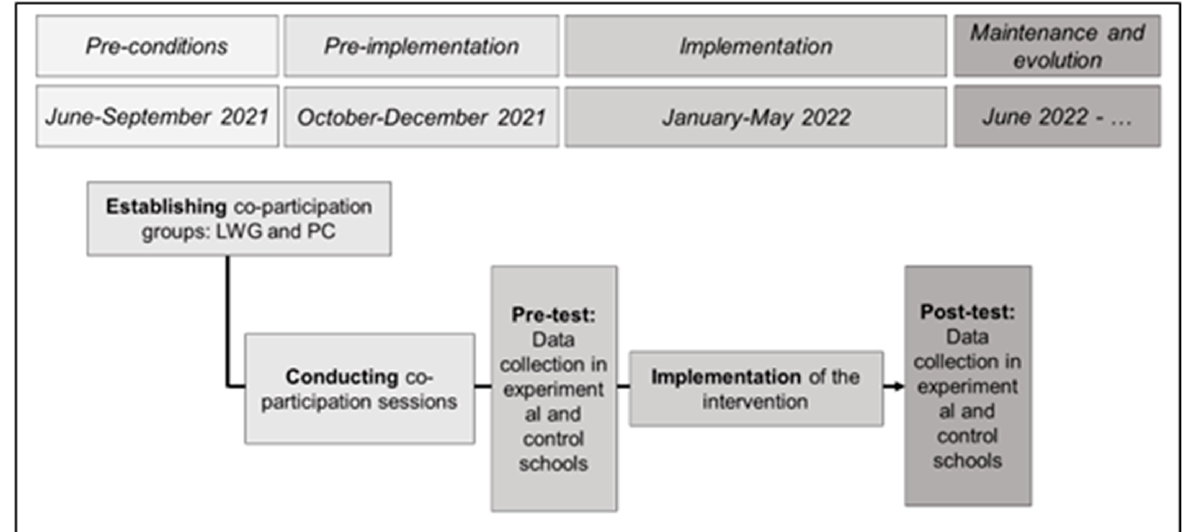
Figure 1. Overall study procedure . Figure 1.